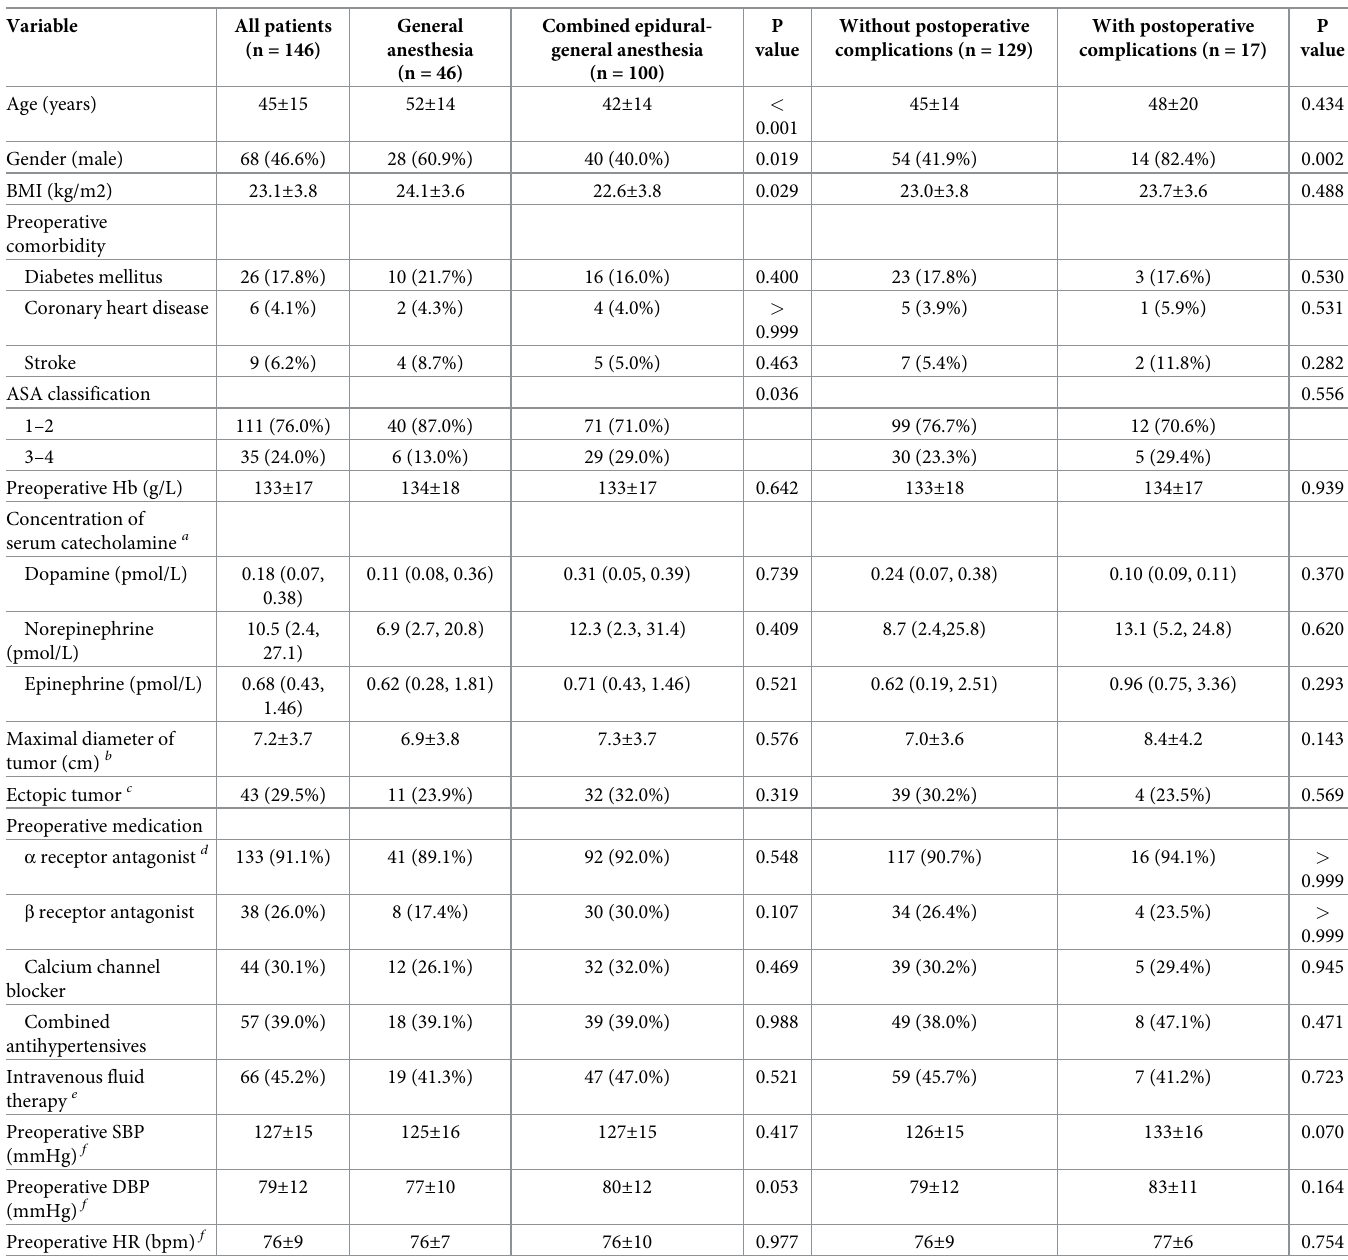
Table 1. Preoperative